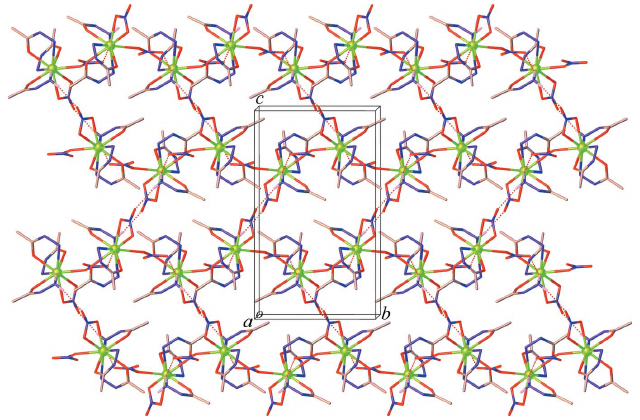
Figure 4 The two-dimensional hydrogen bonded layer in 1 (hydrogen atoms, except those forming hydrogen bonds, are omitted for clarity).